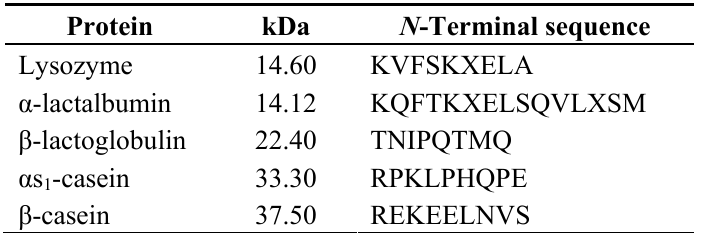
Table 2. Donkey’s milk protein fraction identified by reversed phase chromatography in HPLC  25 